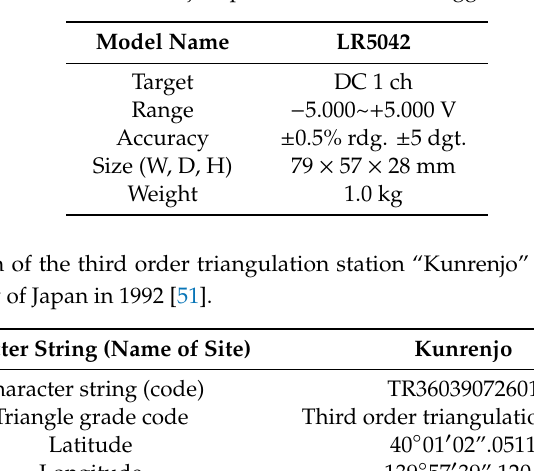
Table A1. Major specifications of data logger.